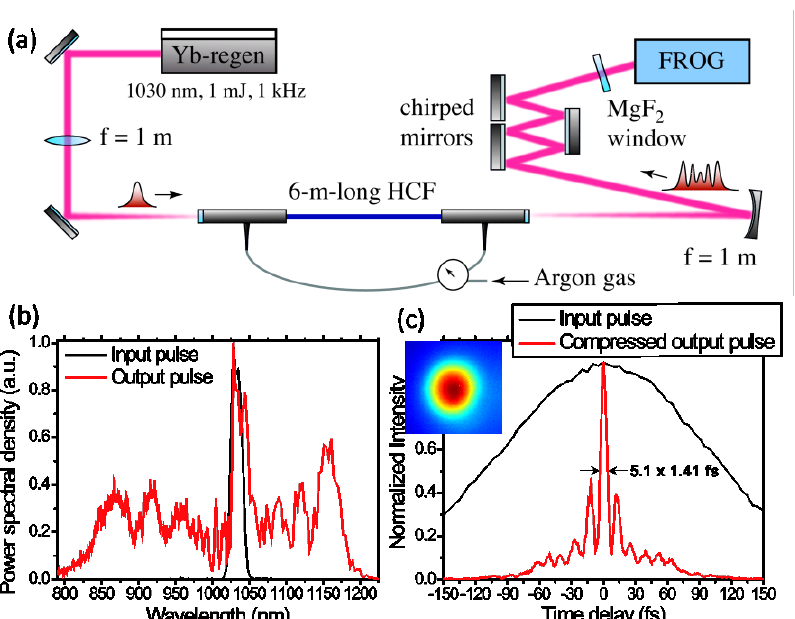
Figure 1. (a) Experimental setup. (b) Spectra of the input (black) and output (red) pulses after propagation through a 6-m-long HCF filled with 1.5 bar of Ar. (inset) the output beam mode profile. (c) Normalized autocorrelation traces of the input pulses (170 fs, black) and the compressed pulses (calculated from FROG measurement) after the optimal GDD compensation (5.1 fs,